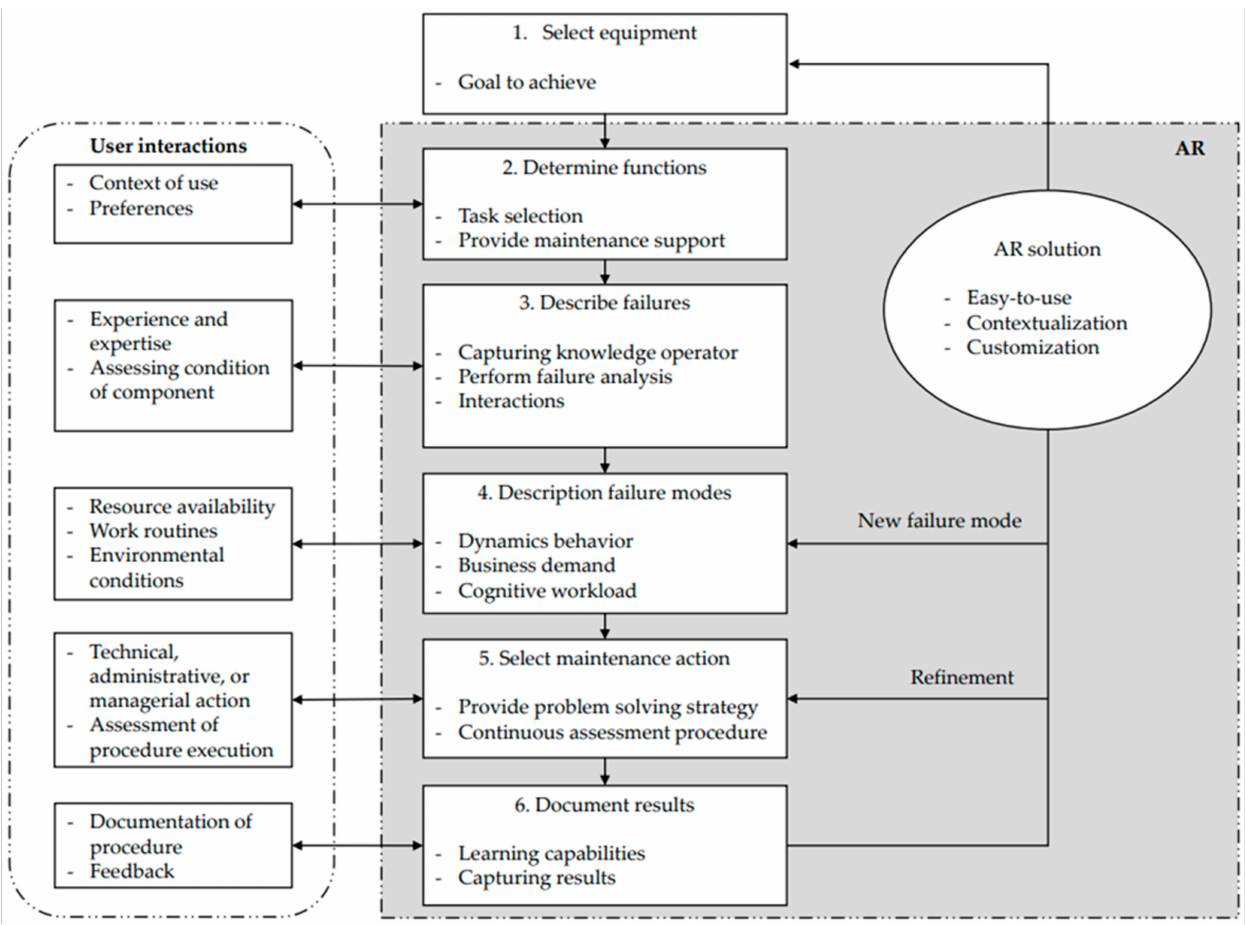
Figure 4. Schematic of the adaptive architectural